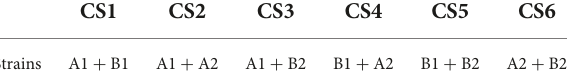
TABLE 2 Consortia formed to screen the strains in Table 1 . CS1 CS2 CS3 CS4 CS5